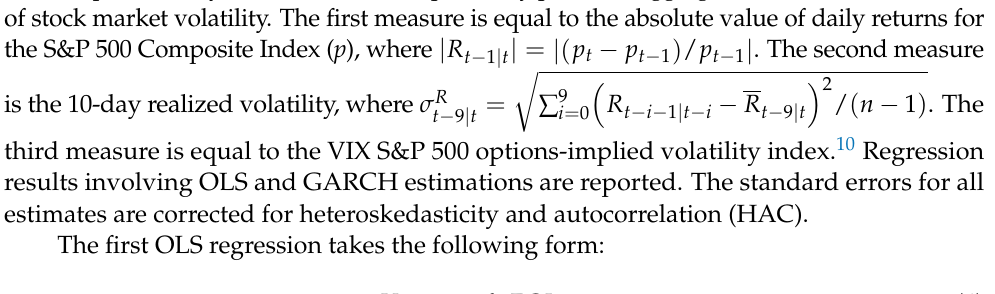
Table 3. OLS Regressions of ECI on Stock Market Volatility.